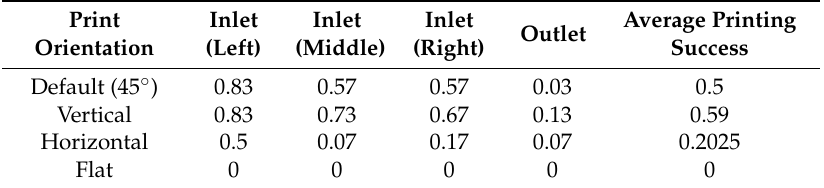
Table 1. Analysis and comparison of print orientations. A 500 µ m channel height chip was printed using the four different possible orientations: the default angle, vertical, horizontal (along the chip’s side), and flat (face-down). The 500 µ m channel height was chosen for this quantification since it was at the threshold of printability. The channels of the chip were injected with red dye, and the fraction of the channel that was open was measured and recorded. For all values presented, there was measurement error of ± 0.03 (1 mm measure per 38 mm channel length). The outlet channel consistently had inferior results due to its further distance from the build platform during printing. Vertical and the default angled orientations provide the best results, as evidenced by the highest average channel success values.